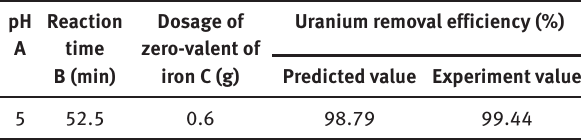
Table 3: Predicted value vs. validation experiment value.